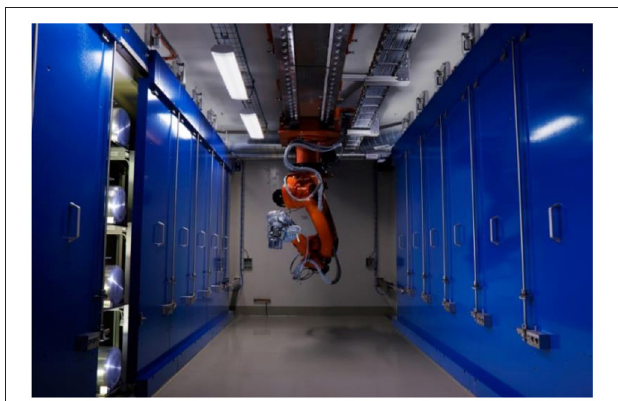
FIGURE 5 | The shielded storage shelves and the